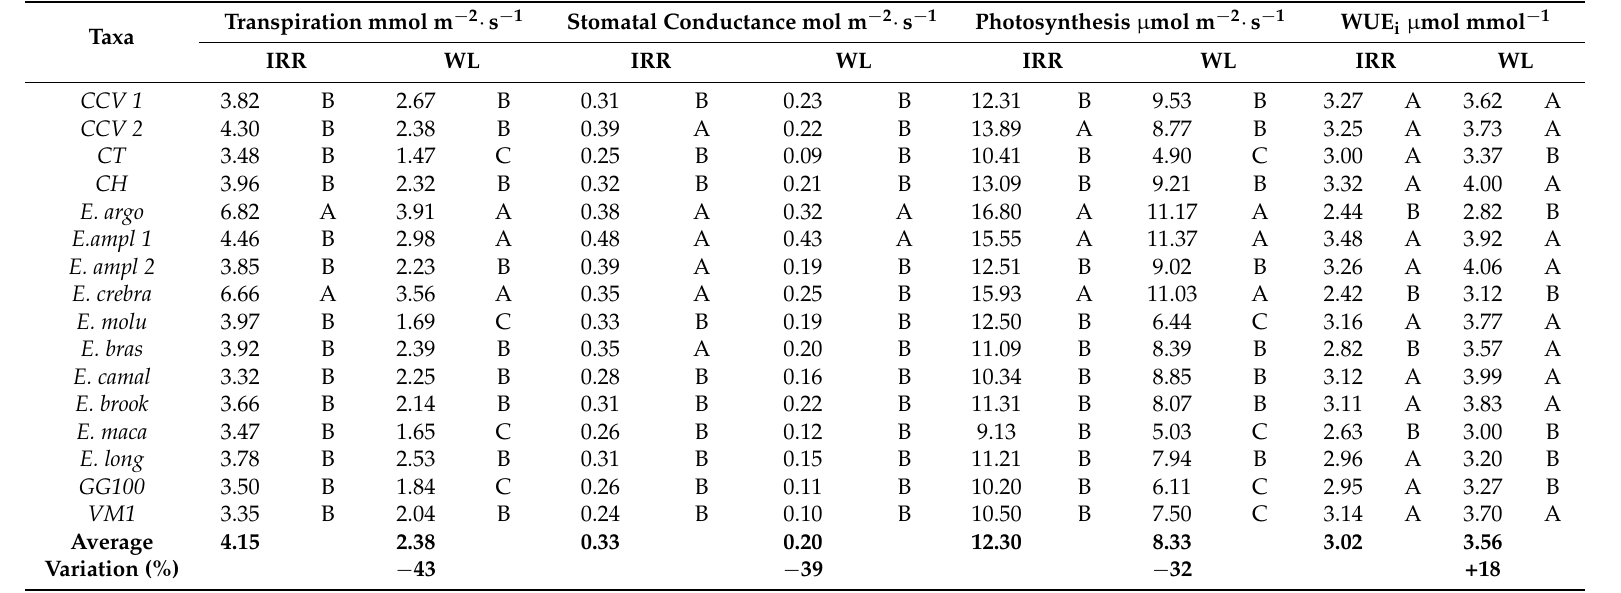
Table 4. Average of four ages of evaluations of physiological variables measured on water limited and irrigated plants. Numbers followed by different letters within each column are statistically different. WUE i : instantaneous water use efficiency in leaf scale; IRR: irrigated; WL: soil water